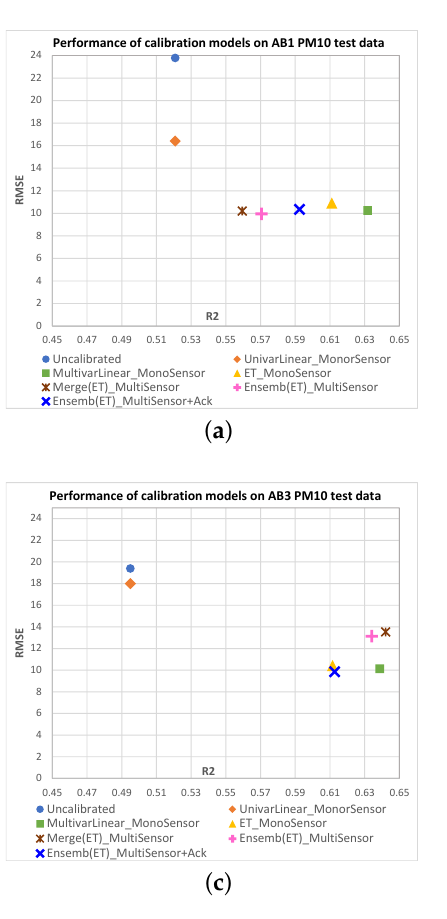
Figure 10. Scatterplots of R 2 vs. RMSE mean values obtained on test data for each IQAir PM 10 sensor as candidate sensor with the different calibration models. The ideal performance is the point with RMSE = 0 and R 2 = 1, which is the lower right corner of the plots. Points closest to that corner represent models with better performance. Subfigures correspond to the following PM 10 candidate sensors: ( a ) HC1; ( b ) HC2; ( c ) HC3; ( d ) HC4.